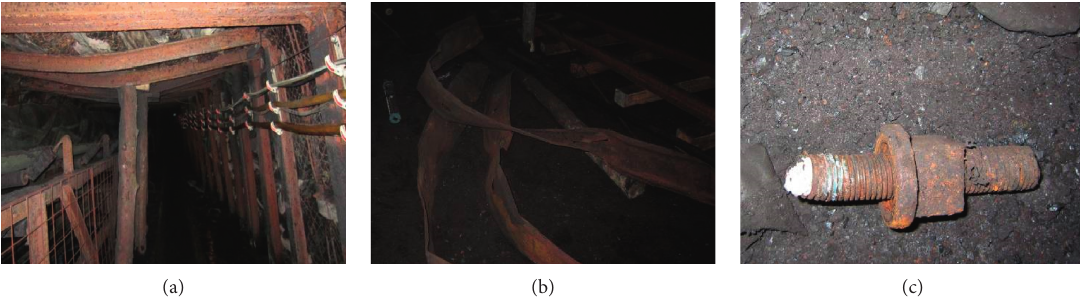
Figure 13: Current status of roadway support. (a) Roof subsidence. (b) Falling steel band. (c) Broken rock